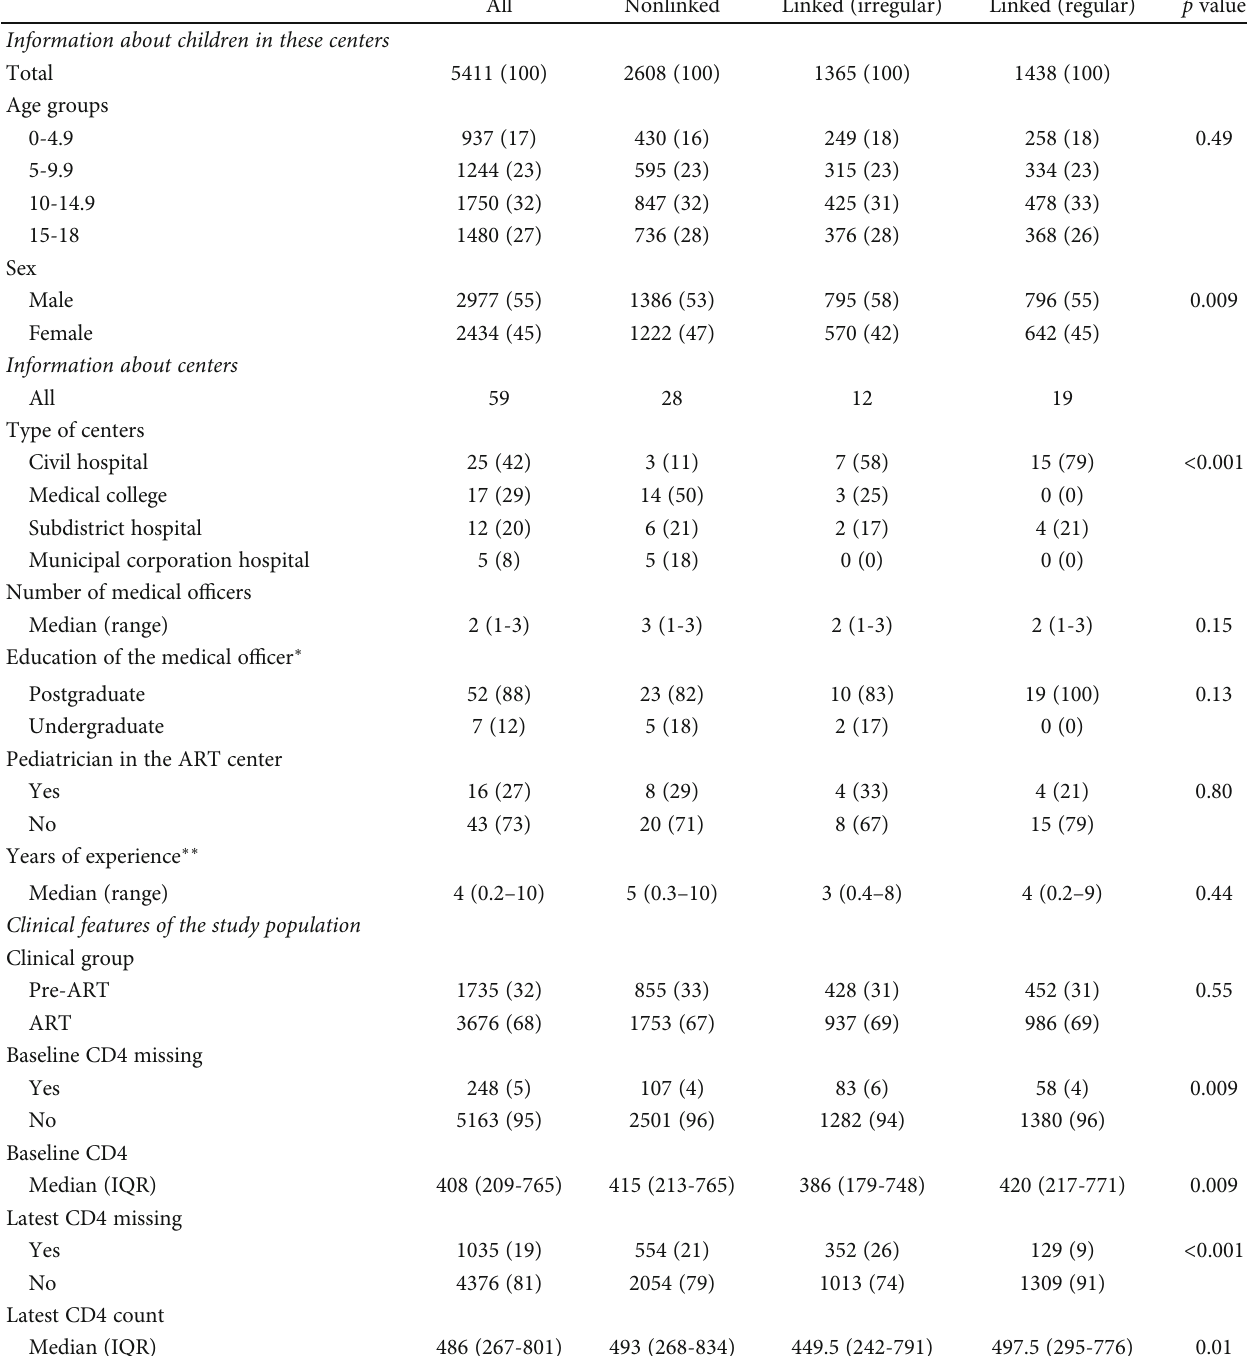
Table 2: Information about the population and other characteristics of 59 ART centers, Maharashtra, India.